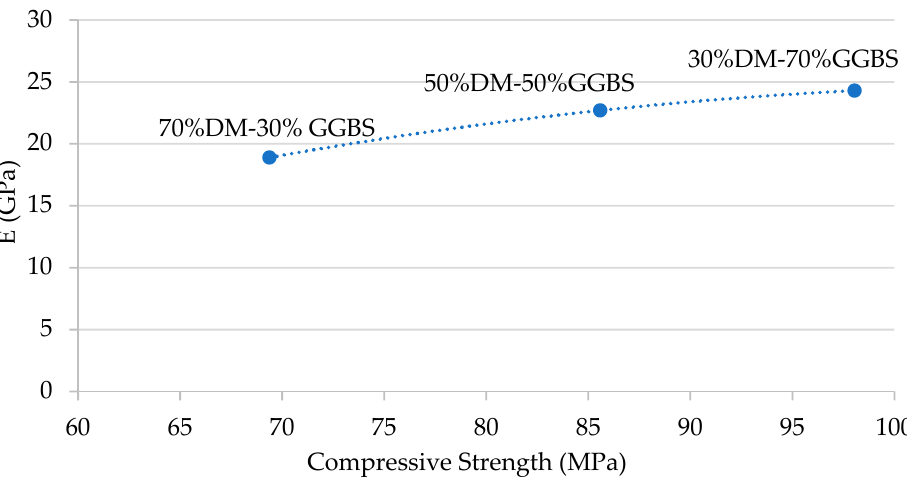
Figure 6. Cracking on Geopolymer Cylindrical Specimen prior to Experimental Testing. 3.2.3. Splitting Tensile Strength The splitting tensile strength of the three geopolymer mixtures developed was exper ‐ imentally determined at 28 ‐ days maturity, following the standard procedure for concrete specimens [29]. The average values obtained per mixture are presented in Table 4. Unlike